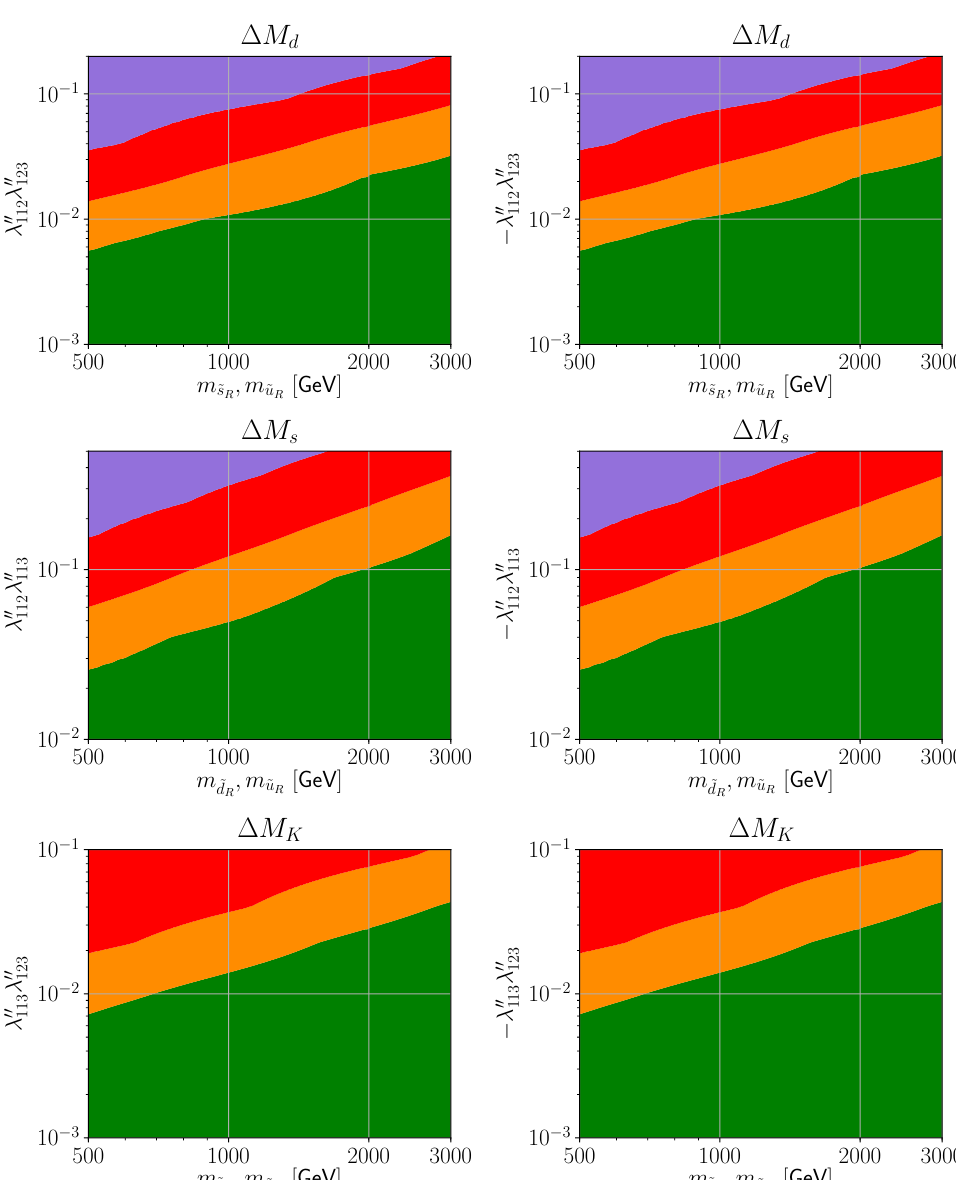
Figure 7. Limits on (cid:22) U 1 (cid:22) D i (cid:22) D j couplings from the meson oscillation parameters. In this case, amplitudes with internal top lines vanish. The color code is similar to that of the previous plots. For these plots, the parameter set of the scenario SUSY-RpV(a) of table 1 has been employed except for the squark masses that are scanned